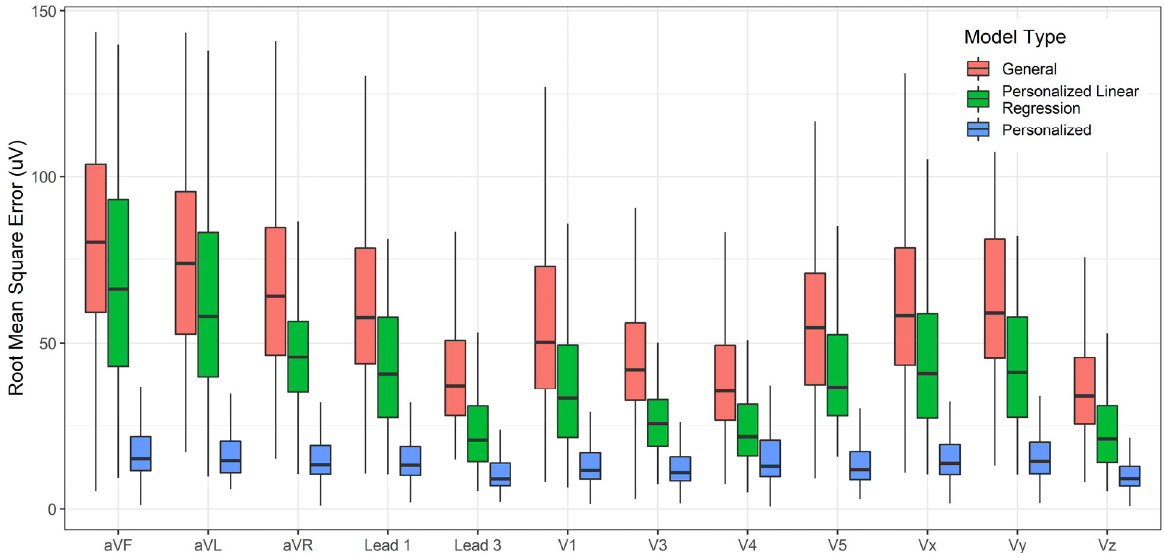
Figure 4. Compare the RMSE of each derived channel between a GM-ECG, personalized linear regression, and PM-ECG for Lead II, V2, and V6 to all other leads transformation model.